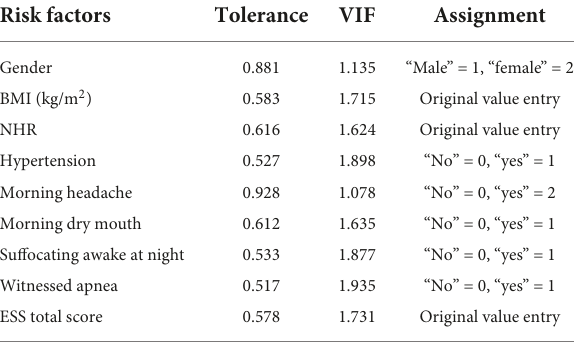
TABLE 2 Multicollinearity test of predictors and the way to assign